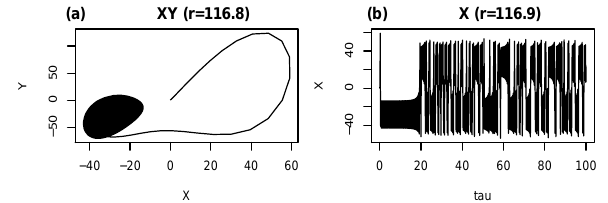
Figure 6. A transition from a stable solution with r = 116.8 to a chaotic solution with r = 116.9 in the 7DLM. The initial conditions are given in Eq. (36a) (i.e., ( X , Y , Z , Y 1 , Z 1 , Y 2 , Z 2 ) = (0, 1, − 1, 0, 0, 0, 0, 0)).